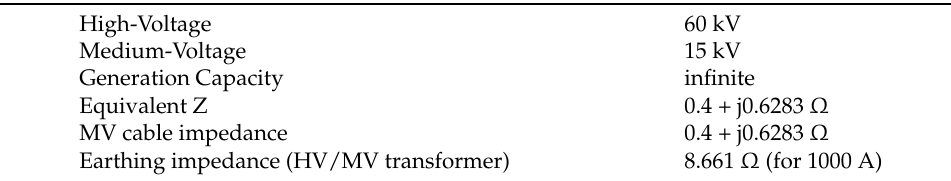
Table 3. Main power system: Main